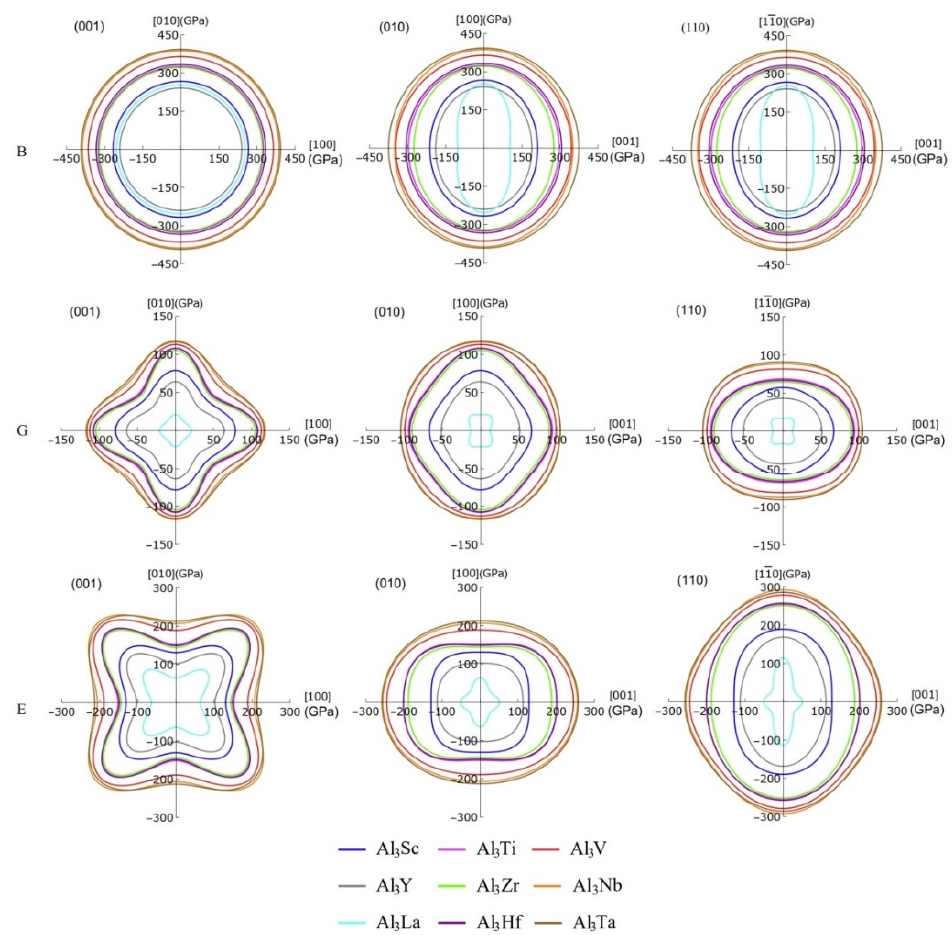
Figure 8. The projections of bulk modulus, shear modulus and Young’s modulus on the (001), (010), and (110) crystal planes of Al 3 TM compounds.